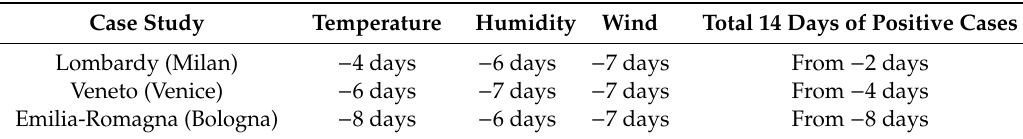
Table 6. The best configuration of the model for the equation.